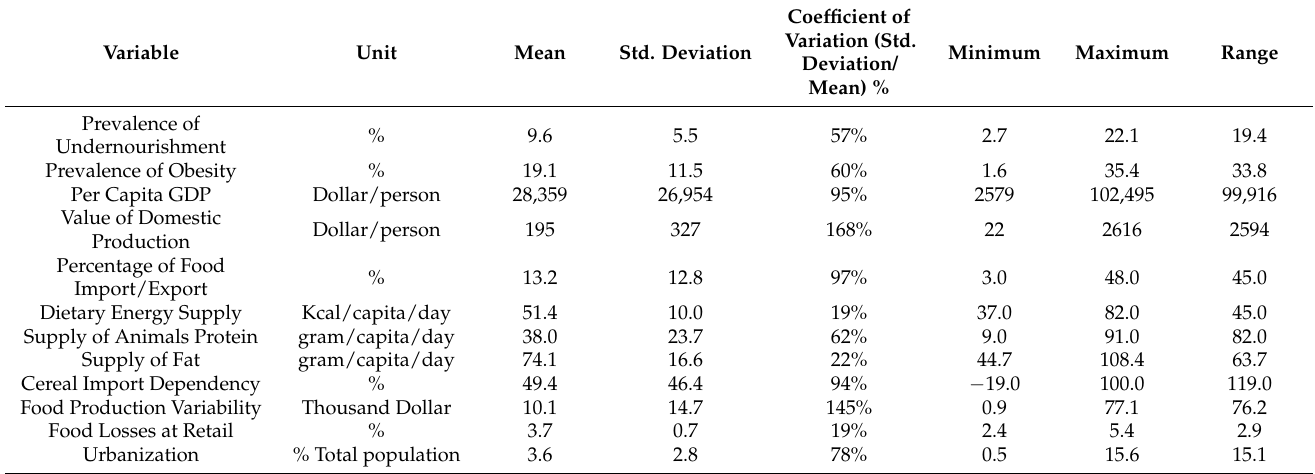
Table 3. Descriptive statistics of the independent and dependent variables.